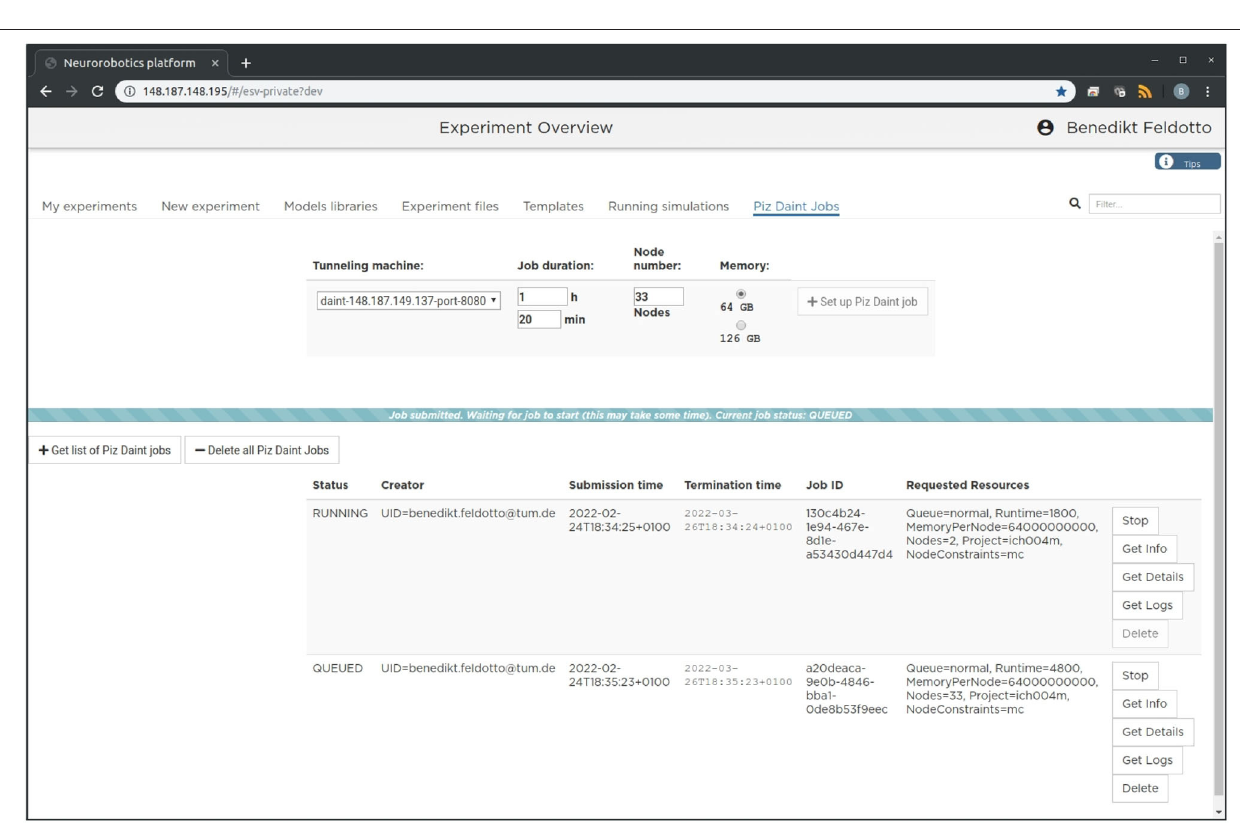
In terms of deployment, the described separation